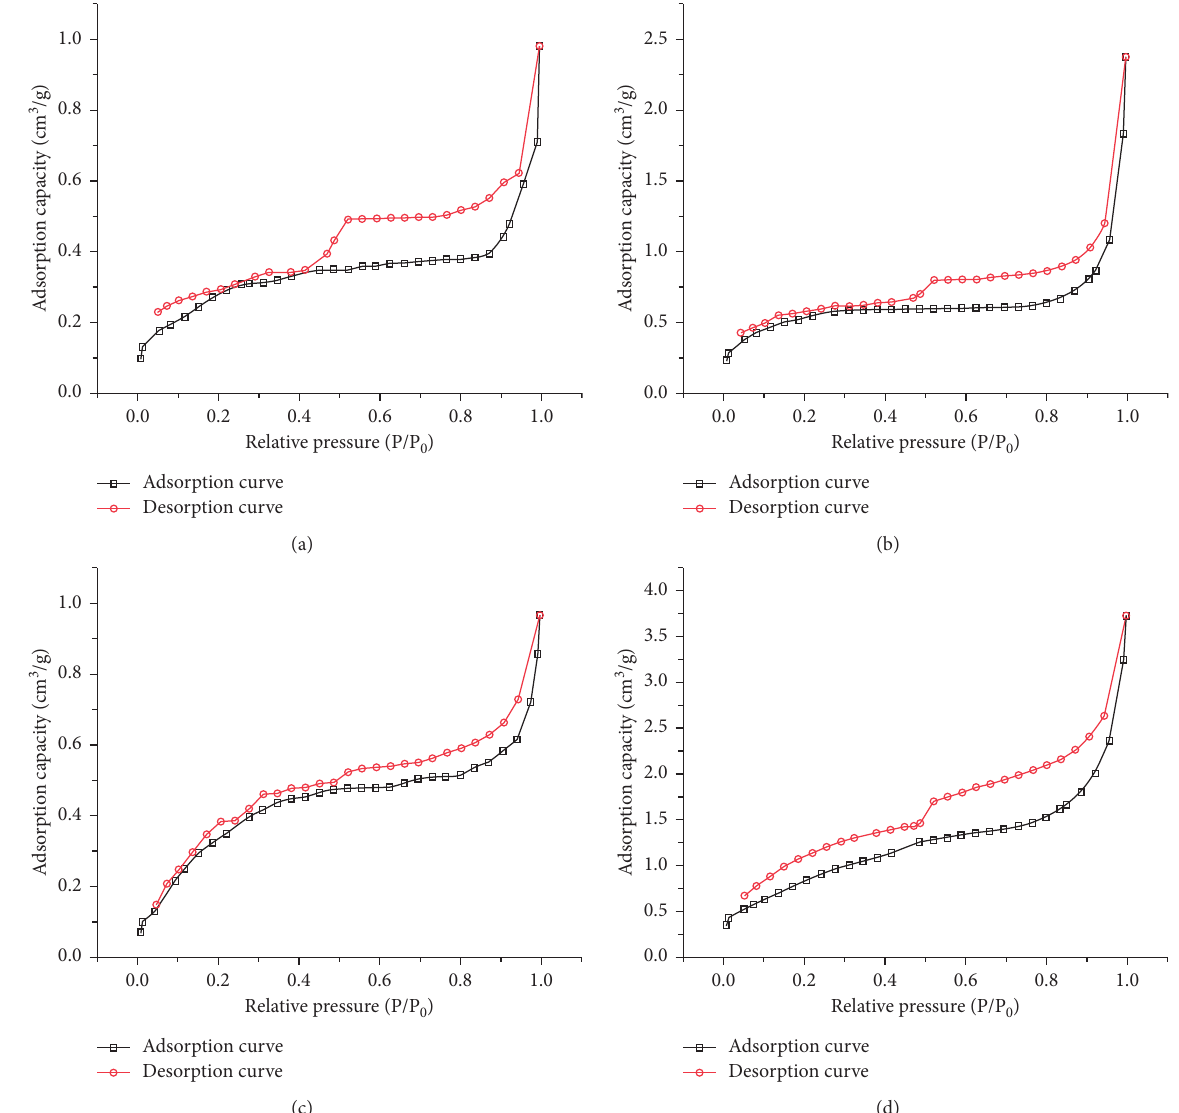
Figure 9: Low-temperature nitrogen adsorption and desorption curves of the coal samples in each coal seam. (a) No. 4 hard coal. (b) No. 4 soft coal. (c) No. 13 hard coal. (d) No. 13 soft